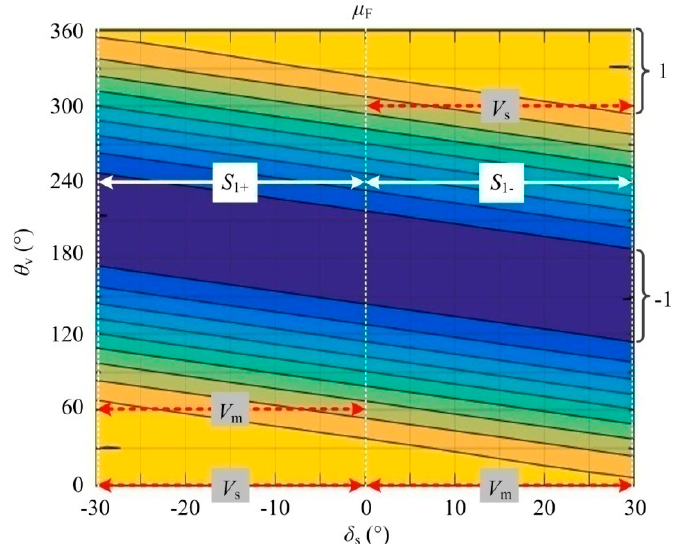
Figure 6. Two-dimensional contour map of flux error active factors. Energies 2019 , 12 , x FOR PEER REVIEW